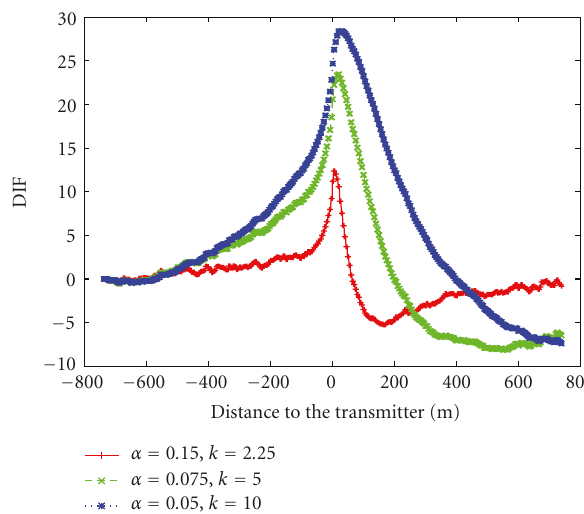
Figure 8: E ff ect of α in WLAN.